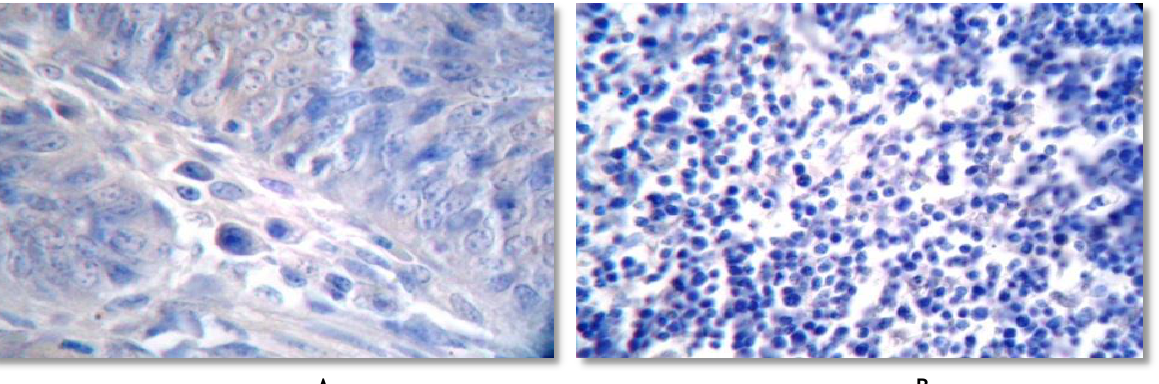
A B Figure,6A:Immunohistochemical staining of the duodenum in heat stressed non treated 24 days old chick G2, the paraffin embedded section (5µm) appears no stained cells. B:Immunohistochemical staining of the bursa of fabricius in heat stressed non treated 24 days old chick G2, the paraffin embedded section (5µm) appears no stained cells. 100 x.